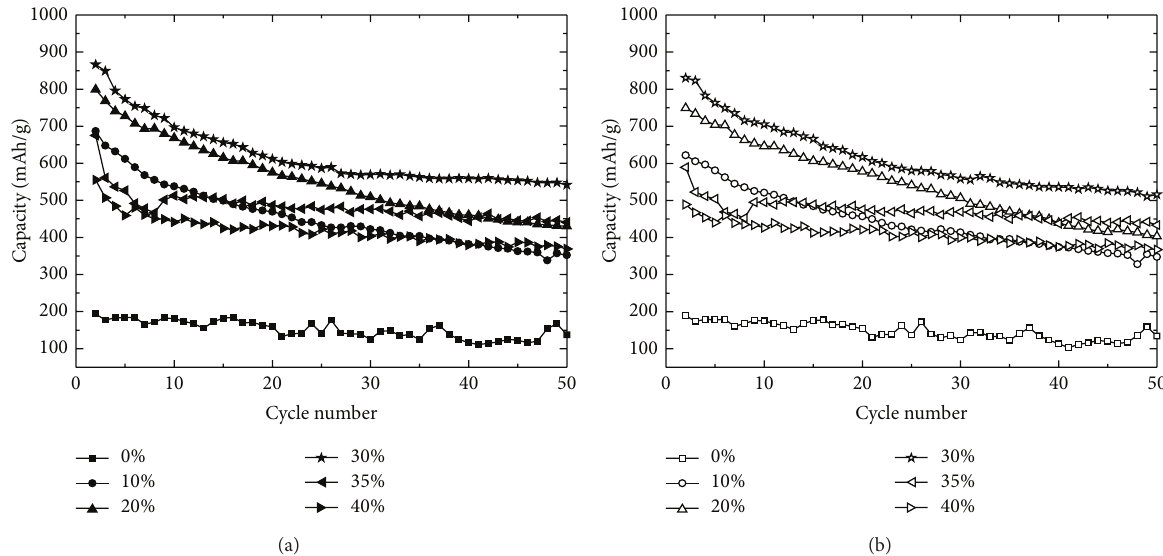
Figure 5: Cyclic stability test results after 2 to 50 cycles for the SiO 𝑥 anode samples with different amounts of pitch carbon (0wt% to 40 wt%) at a fixed amount of 10wt% of conductive carbon blacks; (a) charging state and (b) discharging state.